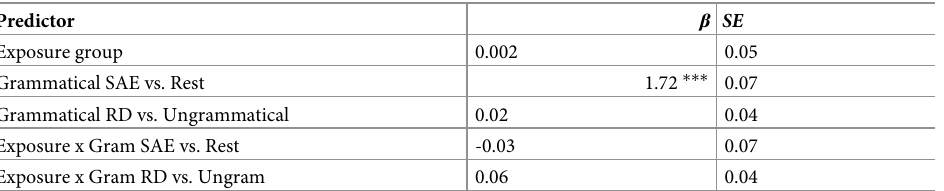
Table 9. Experiment 4 acceptability fixed